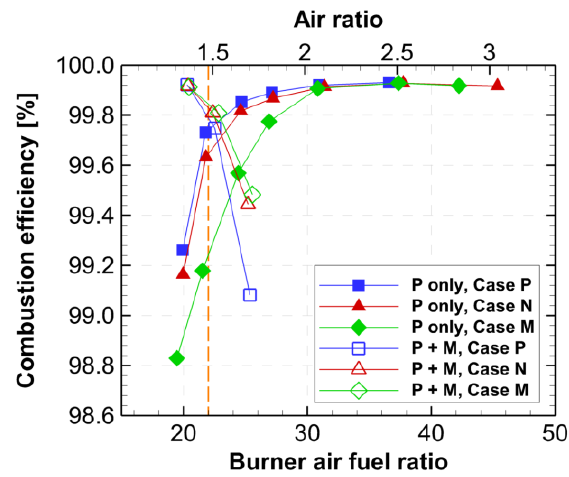
Figure 16. Combustion efficiency under cruising conditions. (Copyright by ASME — "Effects of Fluidic Control of Air-Flow Distribution on Staged Lean Jet Engine Burner," by Yoshida, Schneider, Hassa, Paper No: GT2016-57453).